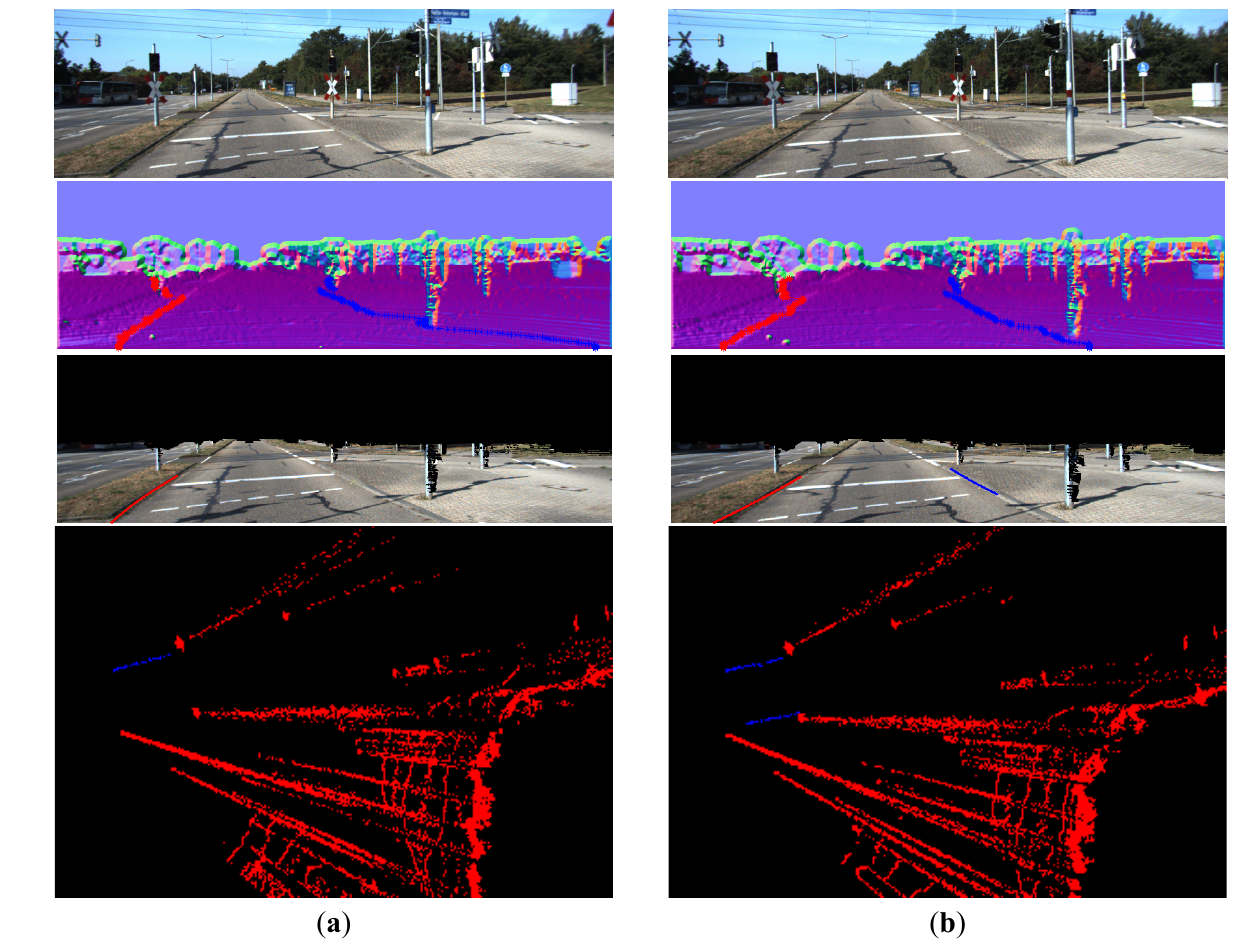
Figure 21. ( a ) Missed curbs; ( b ) Detected